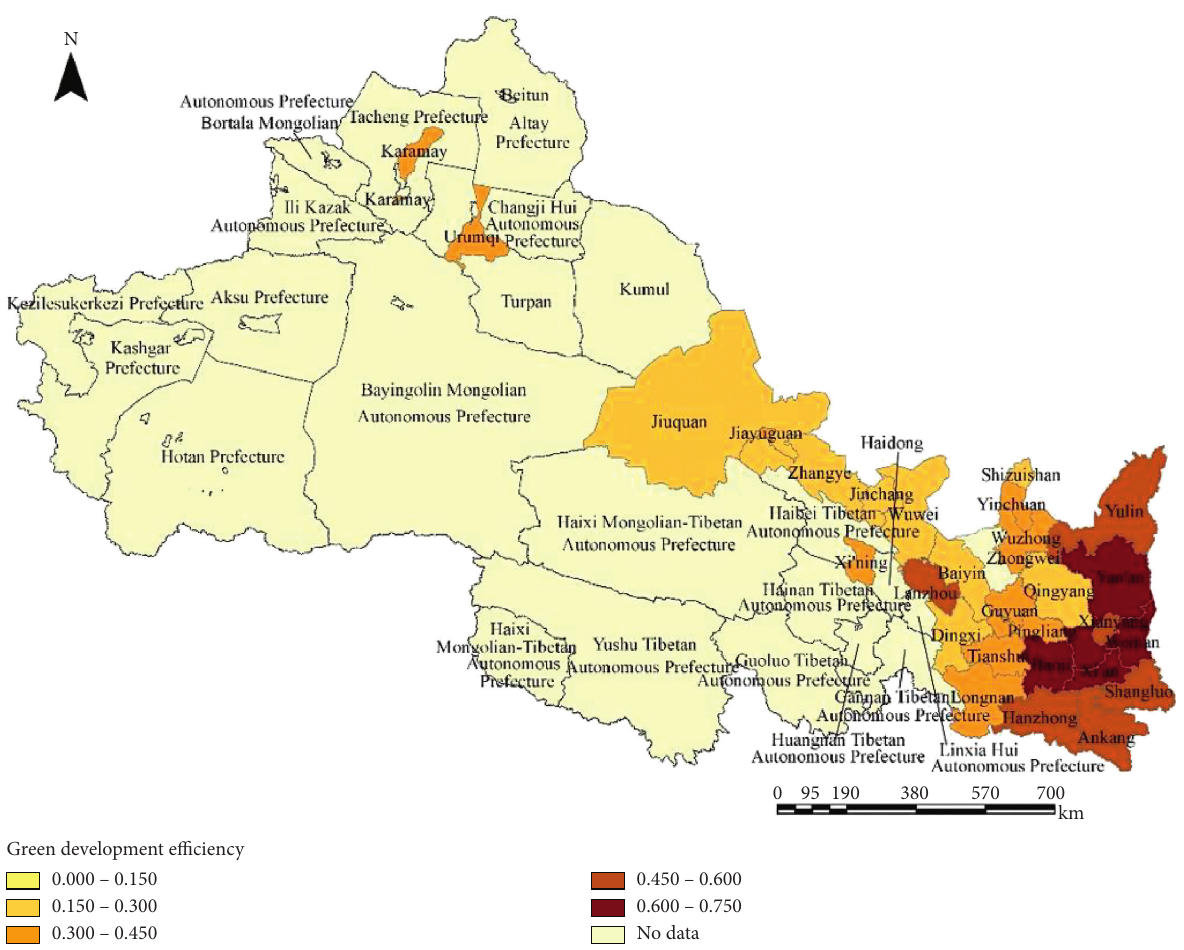
Figure 6: 2017 green development efficiency spatial map of prefecture-level cities in Northwest